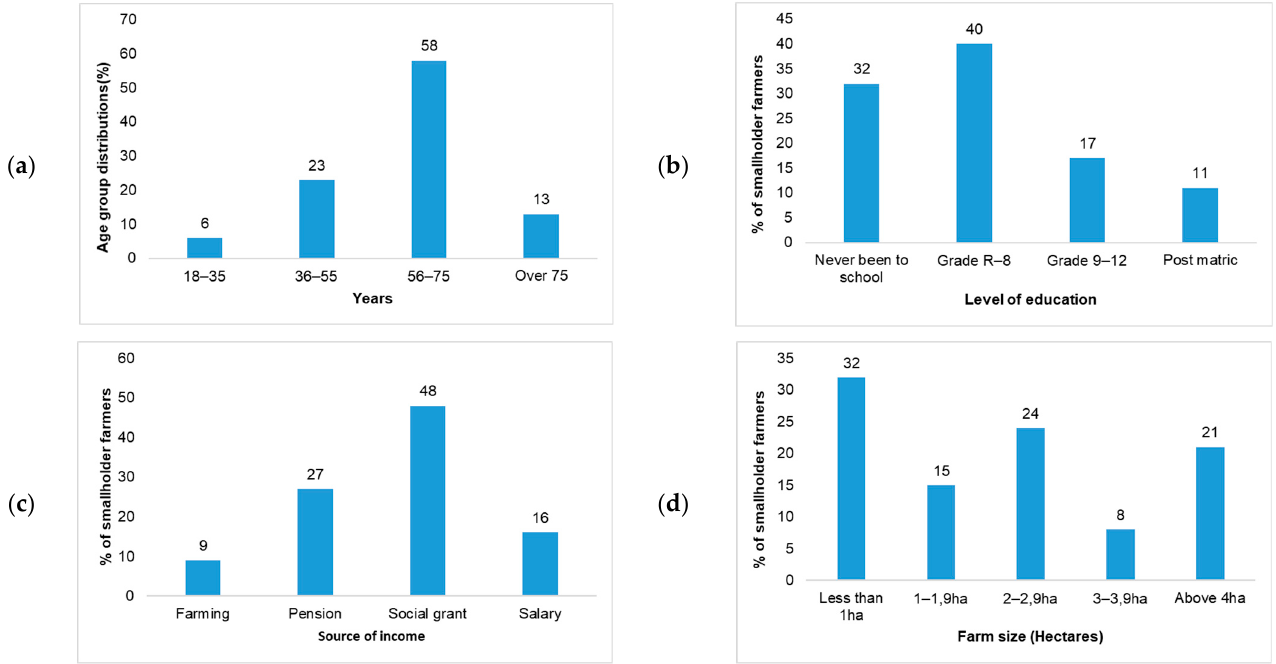
Figure 2. Smallholder farmers ( a ) age group, ( b ) education level, ( c ) source of income, and ( d ) land size in study area ( n = 200).